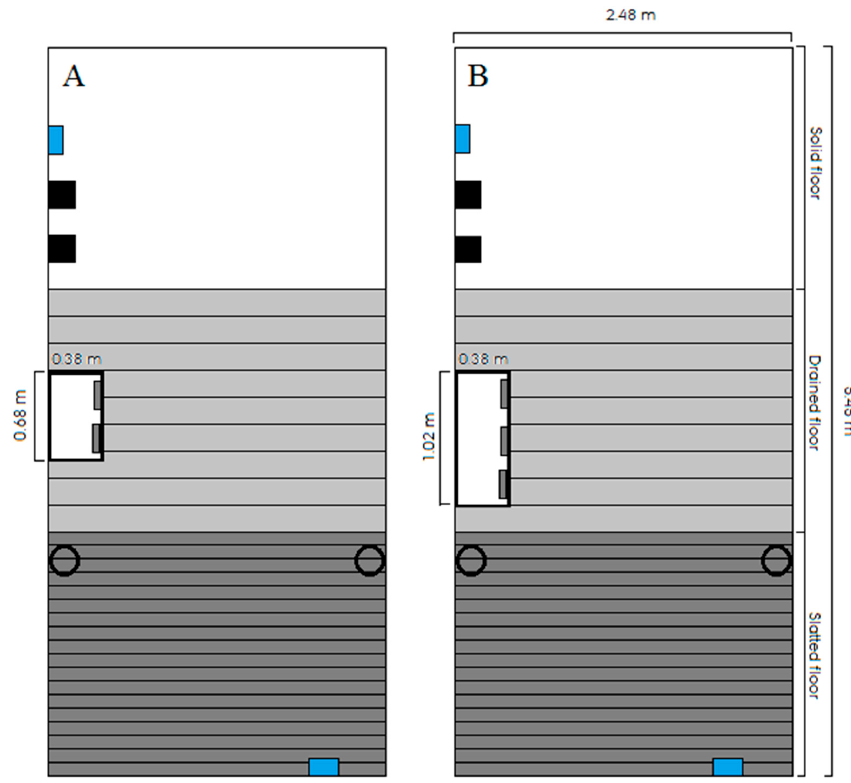
Figure 1. Drawing of pen dimension and design for ( A ) pens with a high space allowance of 1.21 m 2 / pig (11 pigs) and ( B ) pens with a low space allowance of 0.73 m 2 / pig (18 pigs). The white rectangle represents the feeder, and the solid black squares represent two wooden beams in separate vertical racks. The hollow, black circles represent drinking cups, while the blue rectangles represent temperature sensors. All pens had the same dimensions.